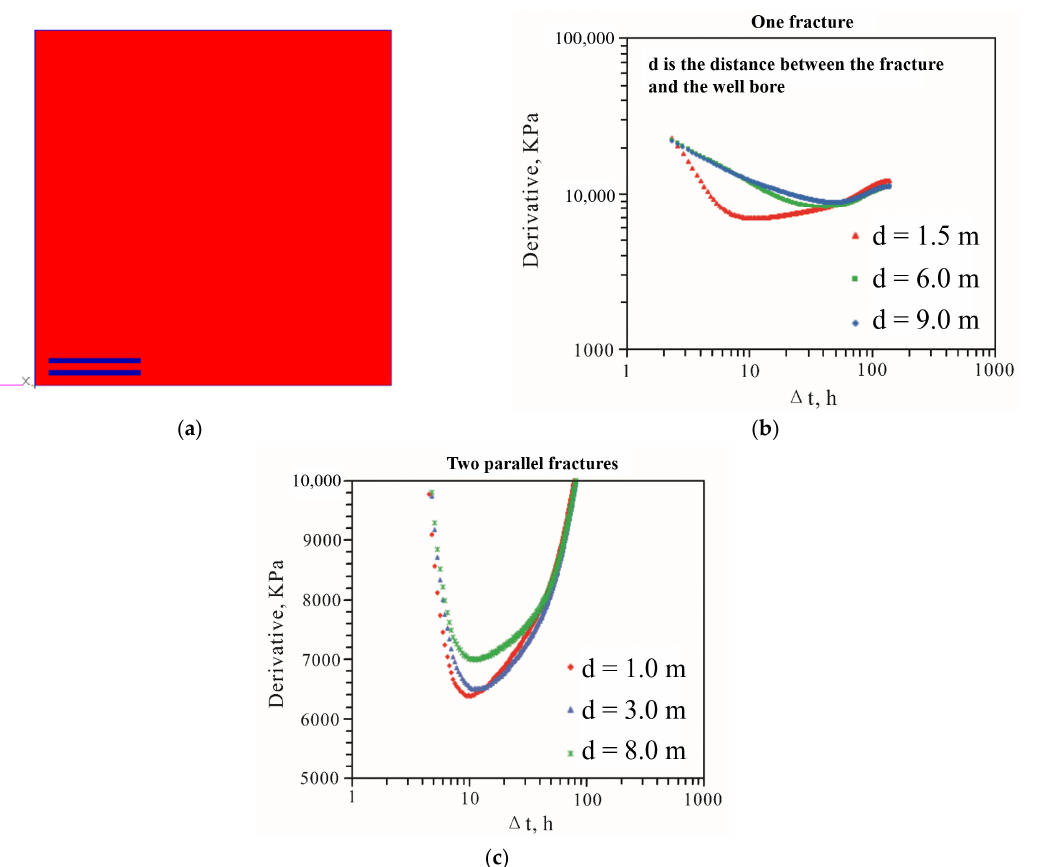
Figure 10. ( a ) Near-wellbore model with two parallel fractures; ( b ) A comparison of the derivative plots for models with different distances between the fracture and the wellbore; ( c ) A comparison of derivative plots with different distances between two parallel fractures.